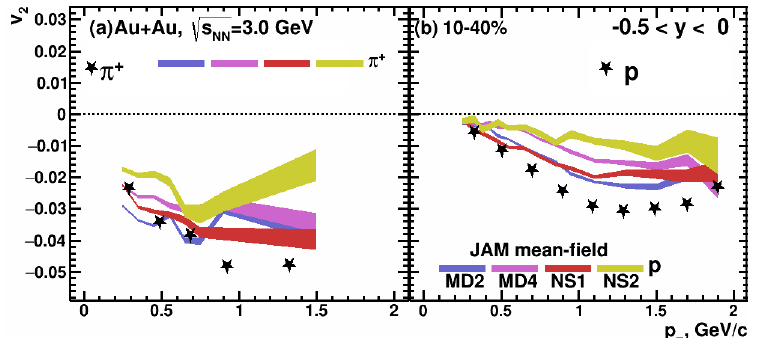
Figure 11. p T dependence of elliptic flow v 2 of pions ( a ) and protons ( b ) in 10–40% central Au + Au √ s NN = 3.0 GeV. The symbols denote the published data from the STAR experiment [15]. collisions at The blue (MD2), purple (MD4), red (NS1) and yellow (NS2) bands represent the results from the mean- field mode of the JAM model with different EOS, as indicated. The uncertainties of the simulated model data are statistical.